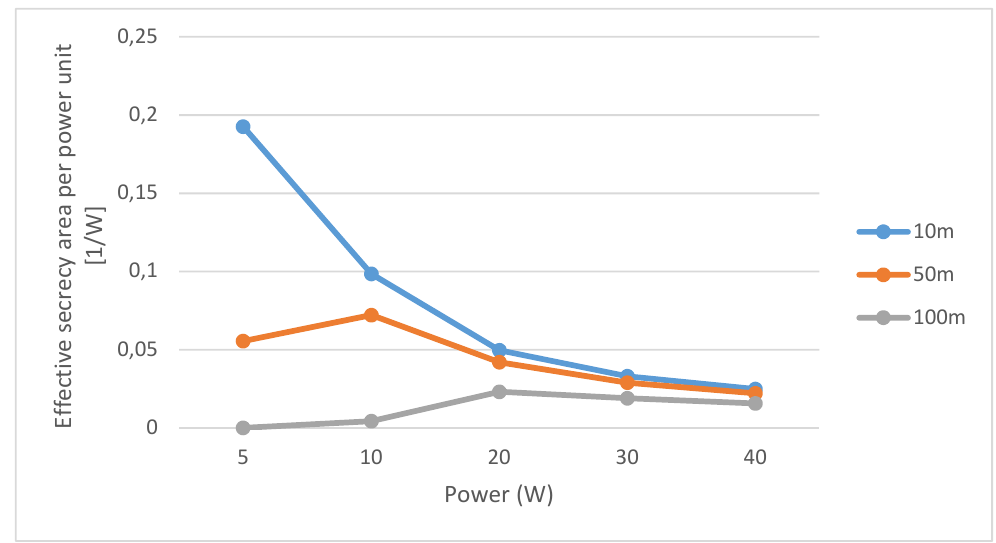
Figure 5. Effective secrecy area versus transmit power as a function of Bob’s distance and transmit